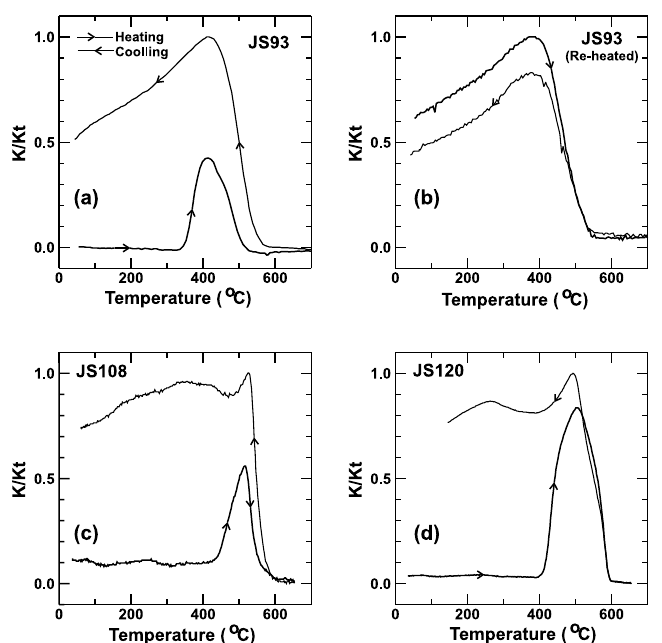
Fig. 5 – Susceptibility variation as a function of temperature in a CS3-KLY3 and MS 2 Bartington equipments, for samples from the reversed (JS-93), normal (JS-108) and topmost (JS-120) portions of the